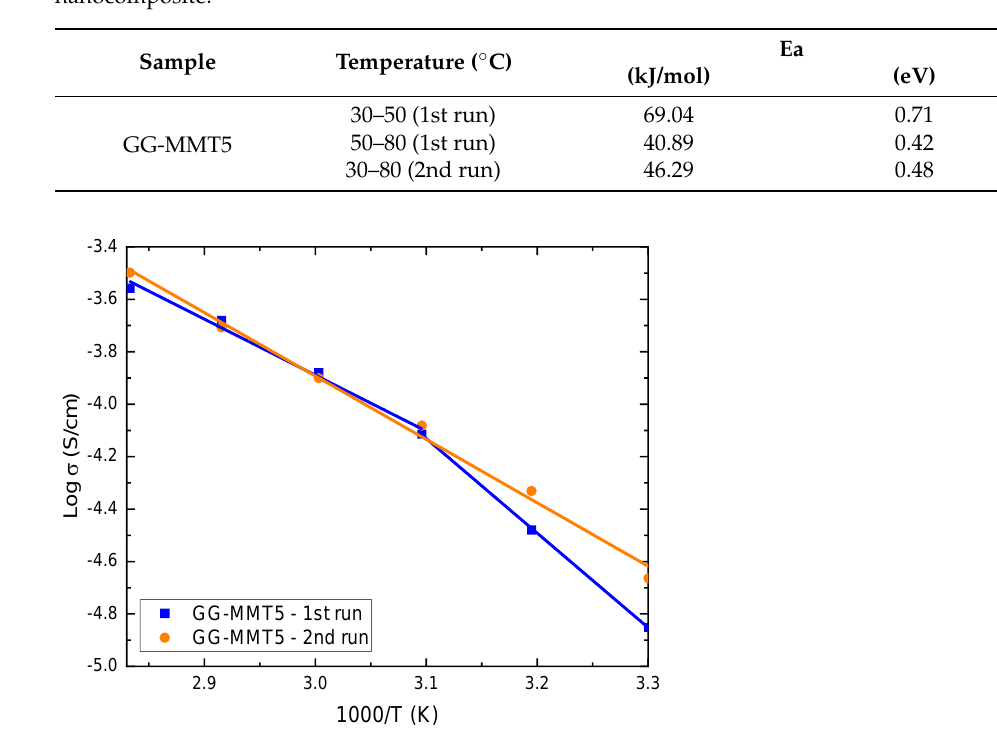
Table 5. The activation energy of two consecutive ion conductivity measurements of the GG-MMT5 nanocomposite.